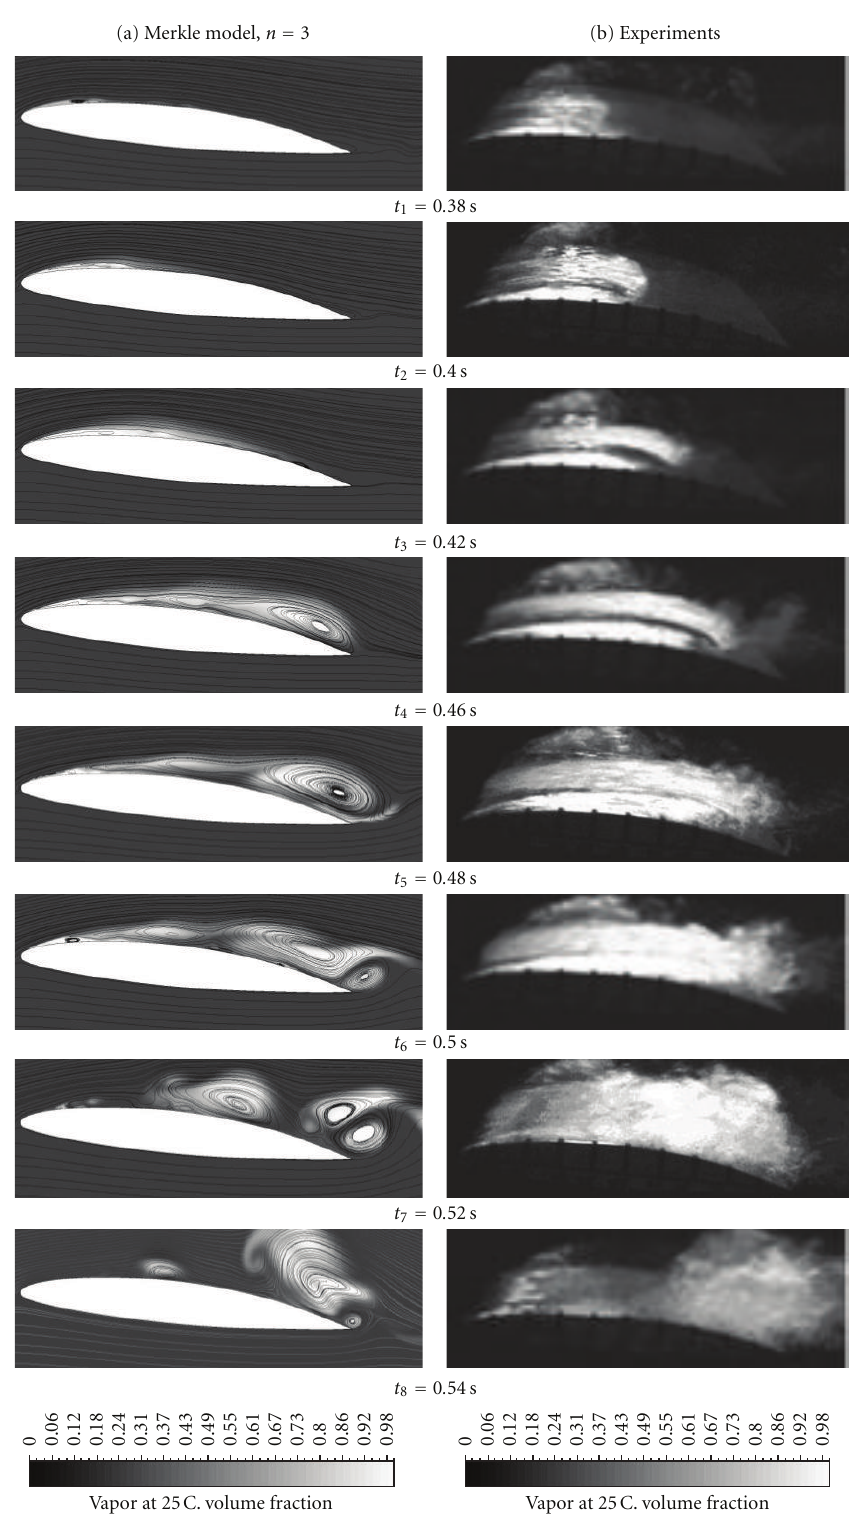
Figure 15: Comparisons of the predicted vapor fraction contours and flow streamlines predicted using the Merkle cavitation model with n = 3 on the left with experimental observations on the right. σ = 1 . 00, Re = 750,000, V